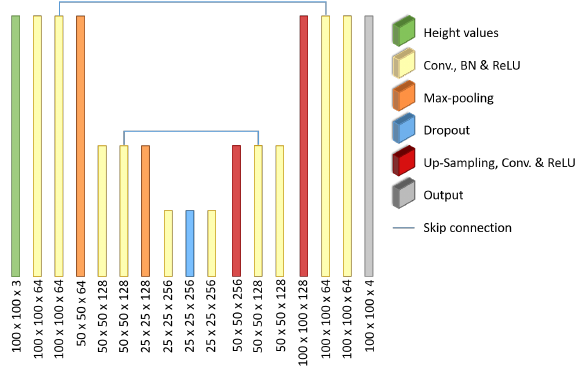
Figure 4. Scheme of our